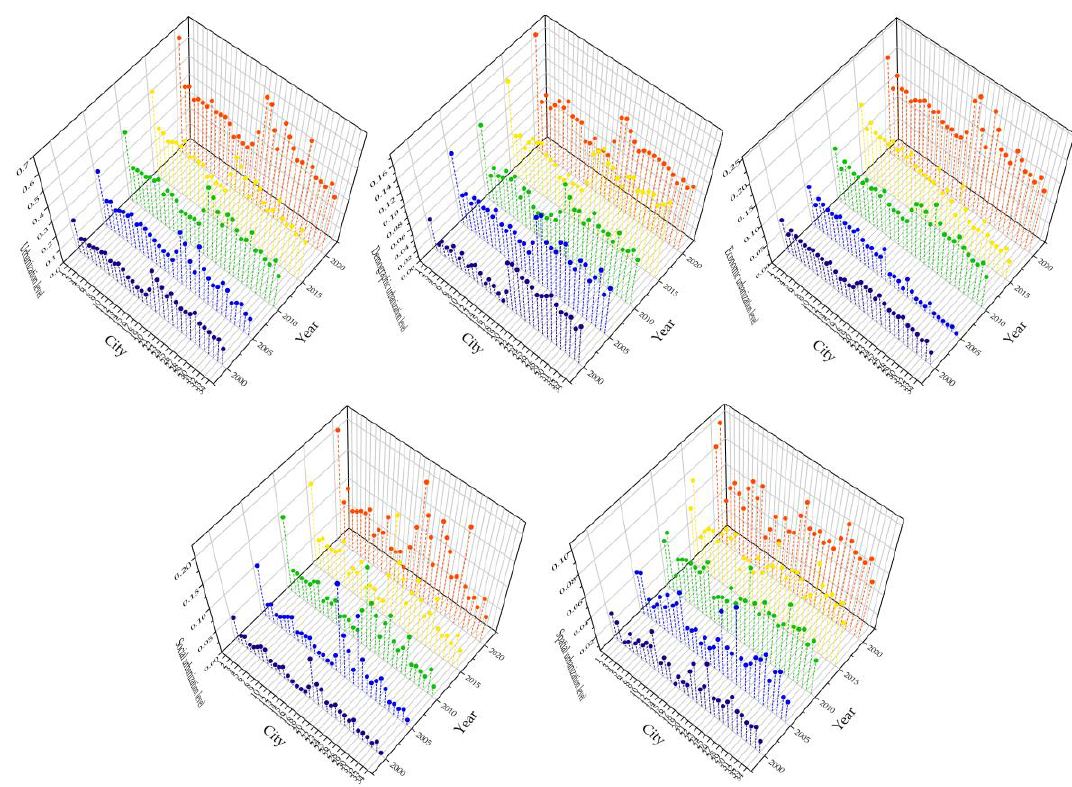
Figure 6. Urbanization levels and subsystem urbanization levels of each city in the Lower Yellow River from 2000 to 2020: (1) Zhengzhou; (2) Kaifeng; (3) Luoyang; (4) Pingdingshan; (5) Anyang; (6) Hebi; (7) Xinxiang; (8) Jiaozuo; (9) Puyang; (10) Xuchang; (11) Luohe; (12) Sanmenxia; (13) Nanyang; (14) Shangqiu; (15) Xinyang; (16) Zhoukou; (17) Zhumadian; (18) Jiyuan; (19) Jinan; (20) Qingdao; (21) Zibo; (22) Zaozhuang; (23) Dongying; (24) Yantai; (25) Weifang; (26) Jining; (27) Taian; (28) Weihai; (29) Rizhao; (30) Linyi; (31) Dezhou; (32) Liaocheng; (33) Binzhou; (34) Heze.